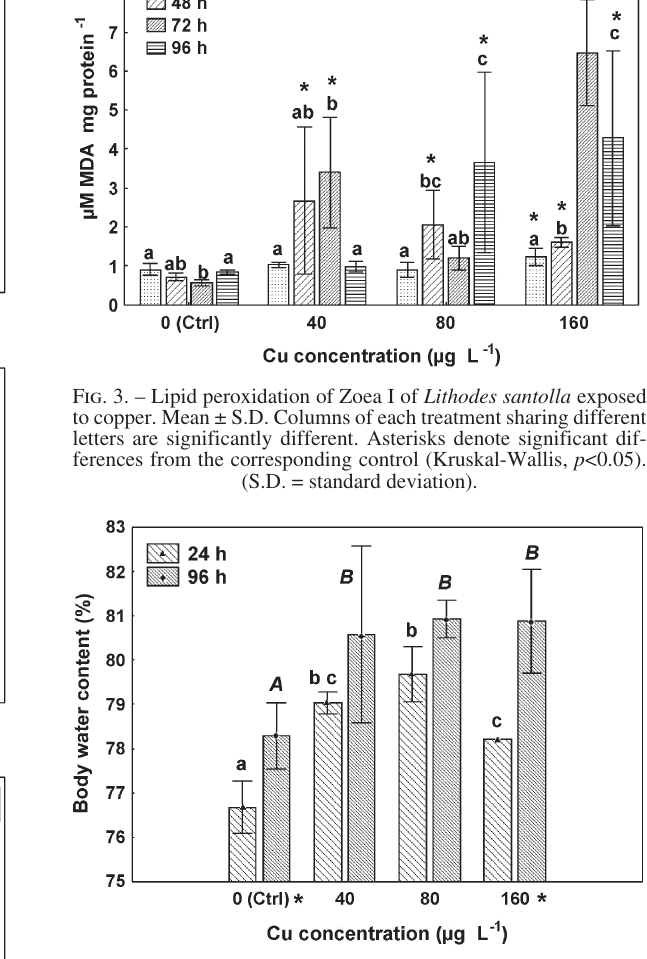
Fig . 4. – Body water content at 24 and 96 h of Zoea I of Lithodes santolla exposed to copper. Mean ± S.D. Columns of each treat- ment and time sharing same letter are not significantly different (ANOVA, p >0.05). Asterisks denote significant differences among exposure time. (S.D.= standard